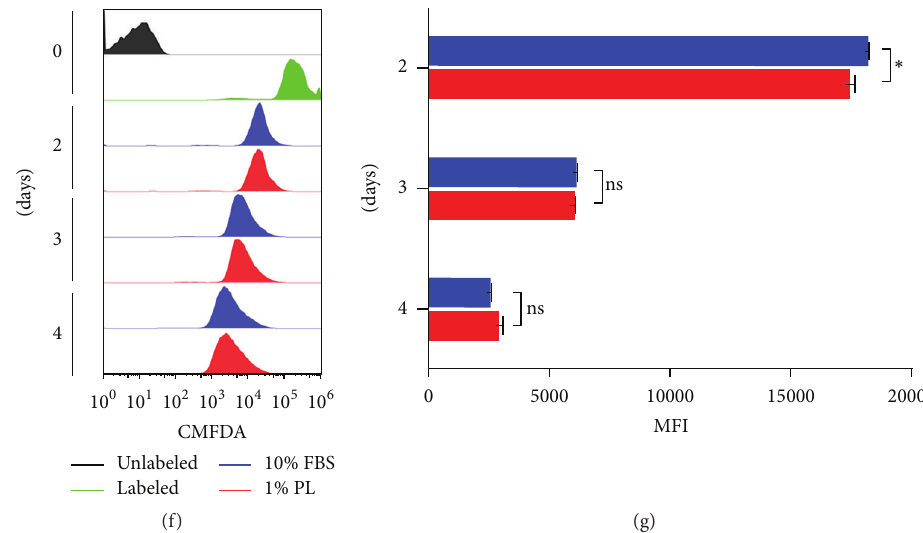
Figure 1: Effect of PL on the growth of DPSCs. (a) Representative images from live/dead fluorescence assay after 5 days of culture in different culture conditions. Green = live; red = dead. (b) Viable counts quantified by ADAM system after 3 days of culture. Data shown as mean + SD, 𝑛 = 3 , statistical significance according to 2-way ANOVA method ( 𝑃 < 0.05 ); ns: not significant. (c) Statistic values (average viability percentages) derived from samples in (b). (d) Viability after long-term culture of 3 weeks. Data shown as mean + SD, 𝑛 = 2 . ns: not significant according to unpaired 𝑡 -test. (e) Cell growth activity measured by PrestoBlue assay. Data shown as mean + SD, 𝑛 = 2 . (f) CMFDA proliferation assay.Time-coursecomparingFBSandPL-selectedcondition.(g)QuantificationofMFIderivedfromsamplesin(f).Statisticsbasedon2-way ANOVA method ( ∗ 𝑃 < 0.05 ). ns: not